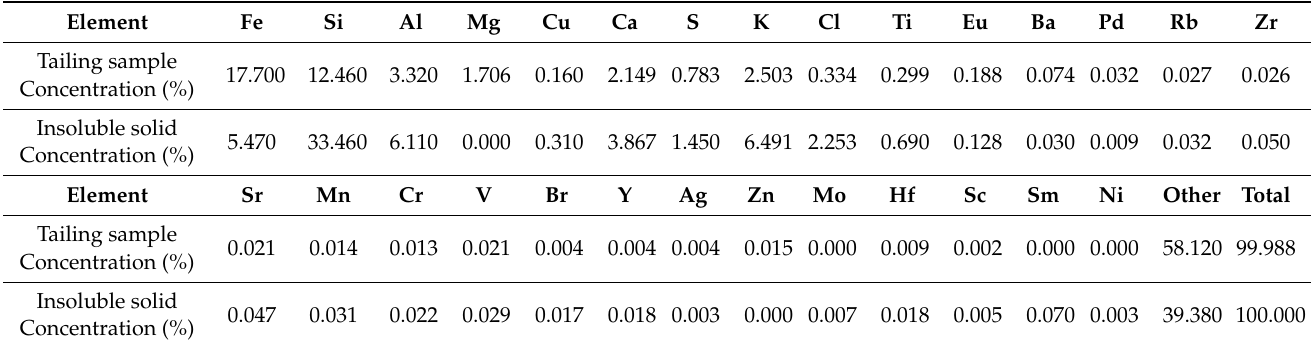
Table 3. Elemental composition of the tailing sample and the insoluble solid obtained by